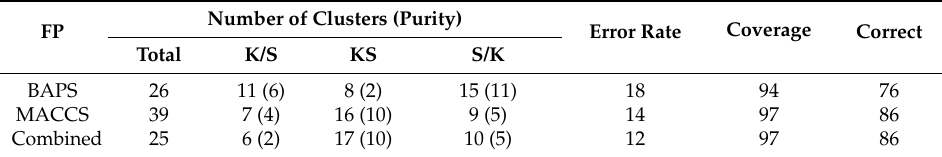
Table 2. Overall SOM performance against all cathepsins inhibitors.